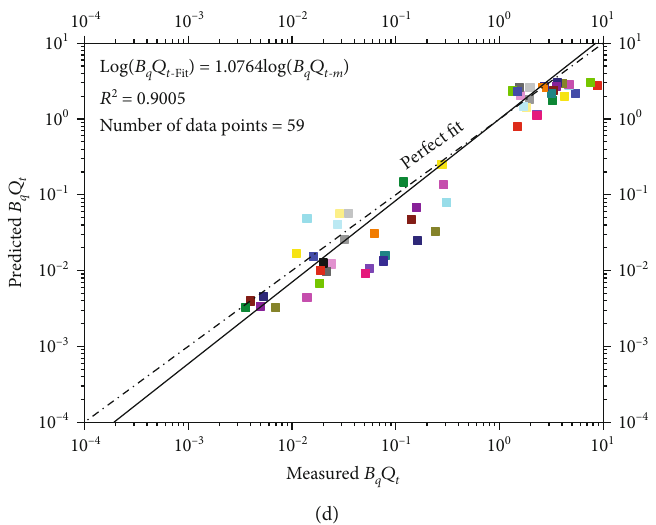
Q ff erent curves: (a) bilinear, (b) arc, (c) parabola, and (d) ellipse (data from this q t values for di